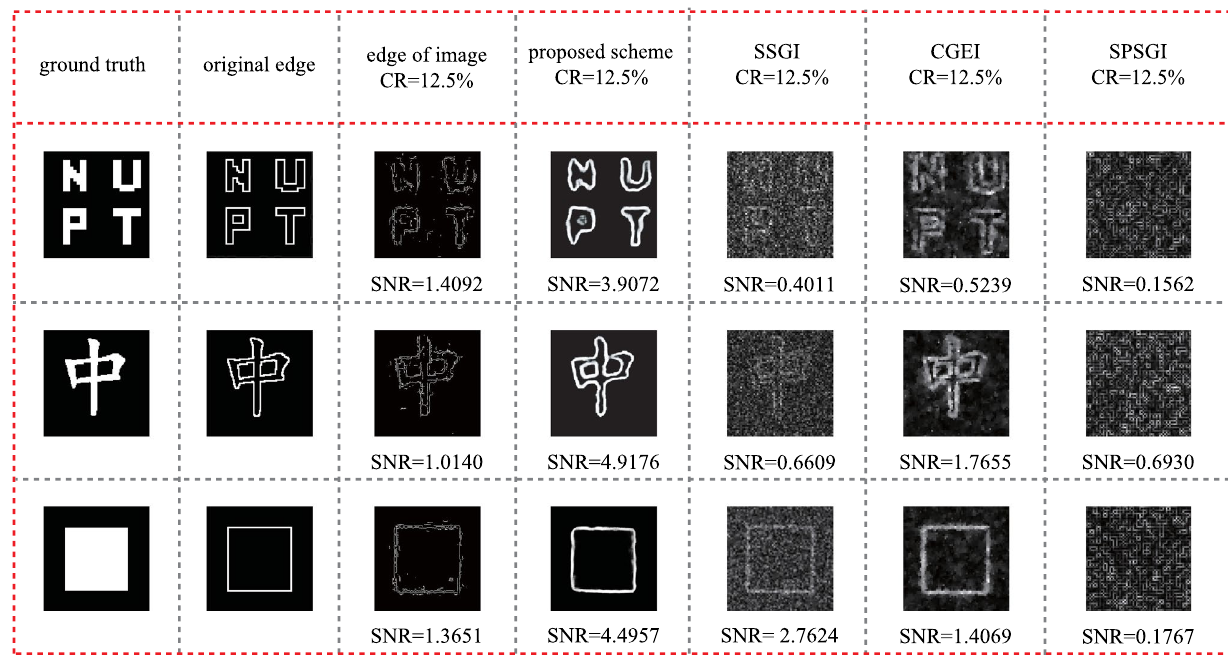
Comparison of the proposed scheme with those results by using SSGI scheme, CGEI scheme, SPSGI scheme with random speckle pat- terns, together with edge of image when CR =